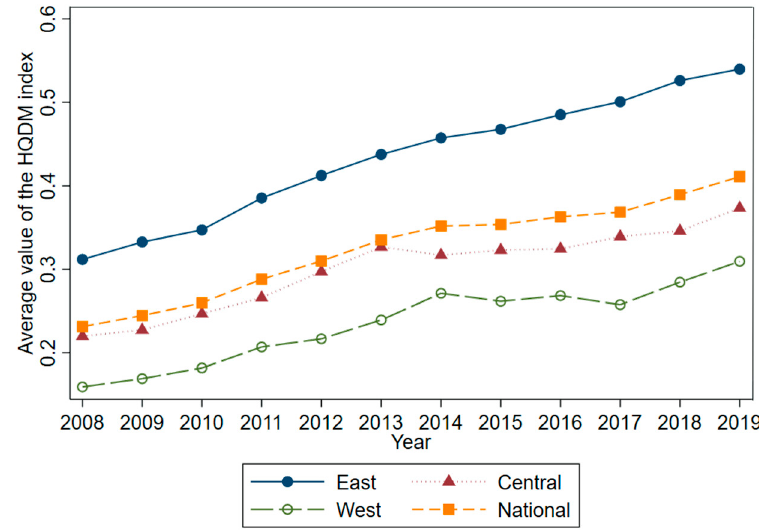
Figure 3. Change in the average value of the HQDM index, both nationally and regionally, for the period 2008–2019.